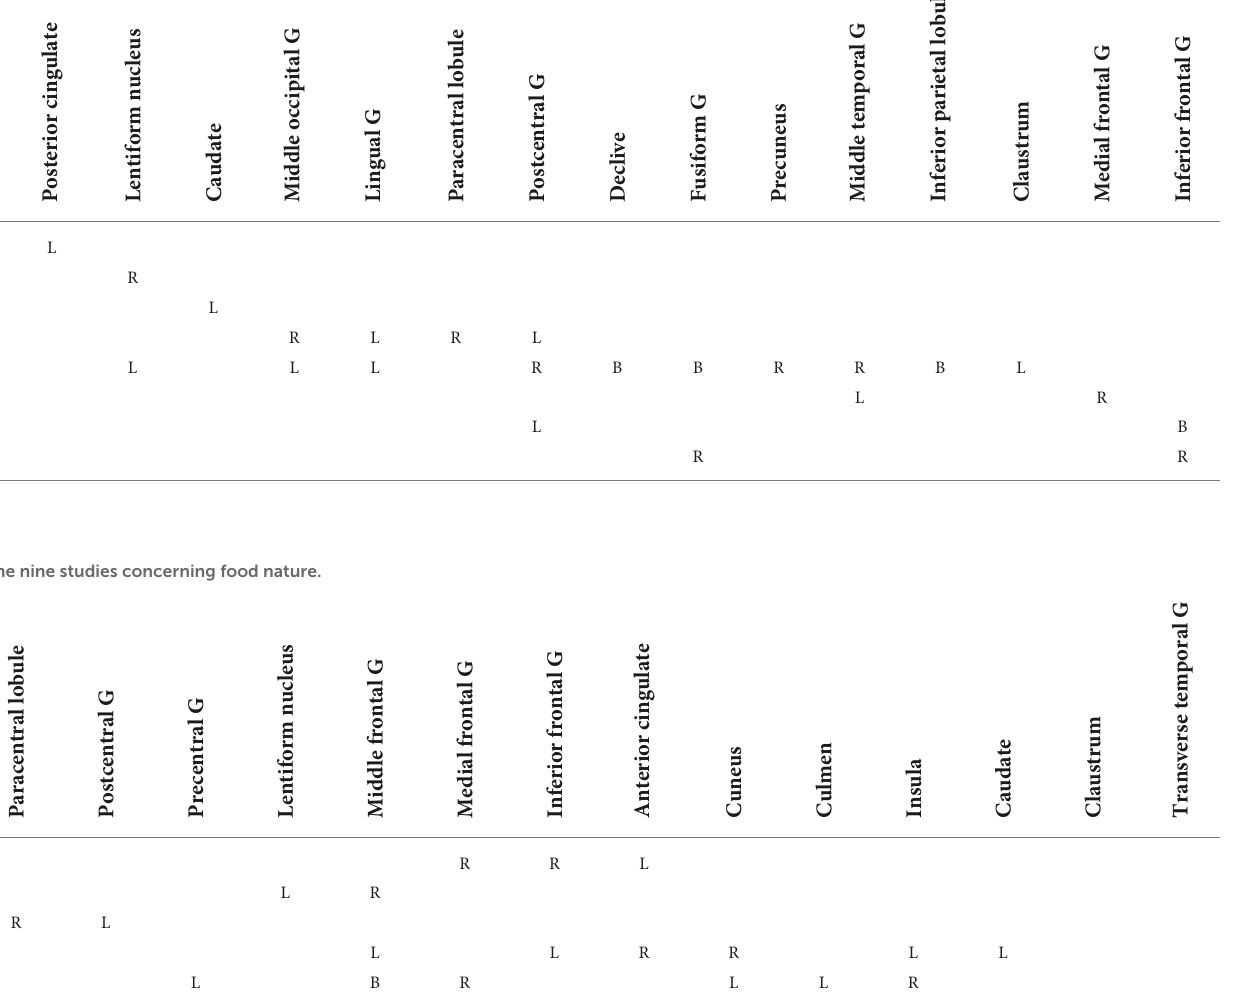
TABLE 2 Qualitative label-based meta-analysis of the eight studies concerning food brand.